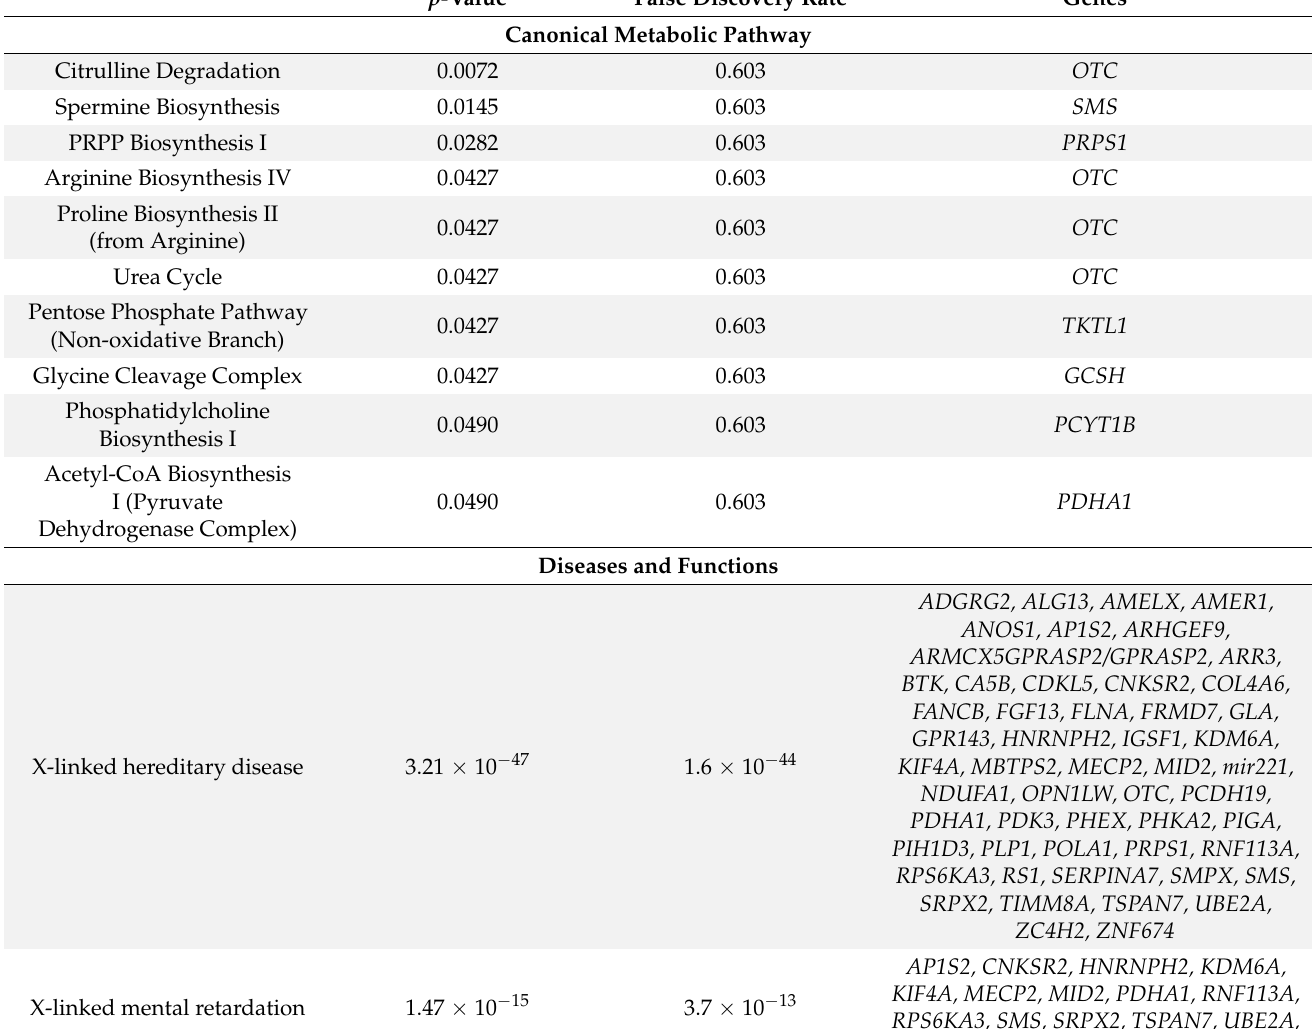
Table 5. Top 10 canonical metabolic pathways and diseases and functions identified using the list of positional candidate genes mapped around (100 Kb up- and downstream) from candidate SNPs or within haplotype coordinates showing significant